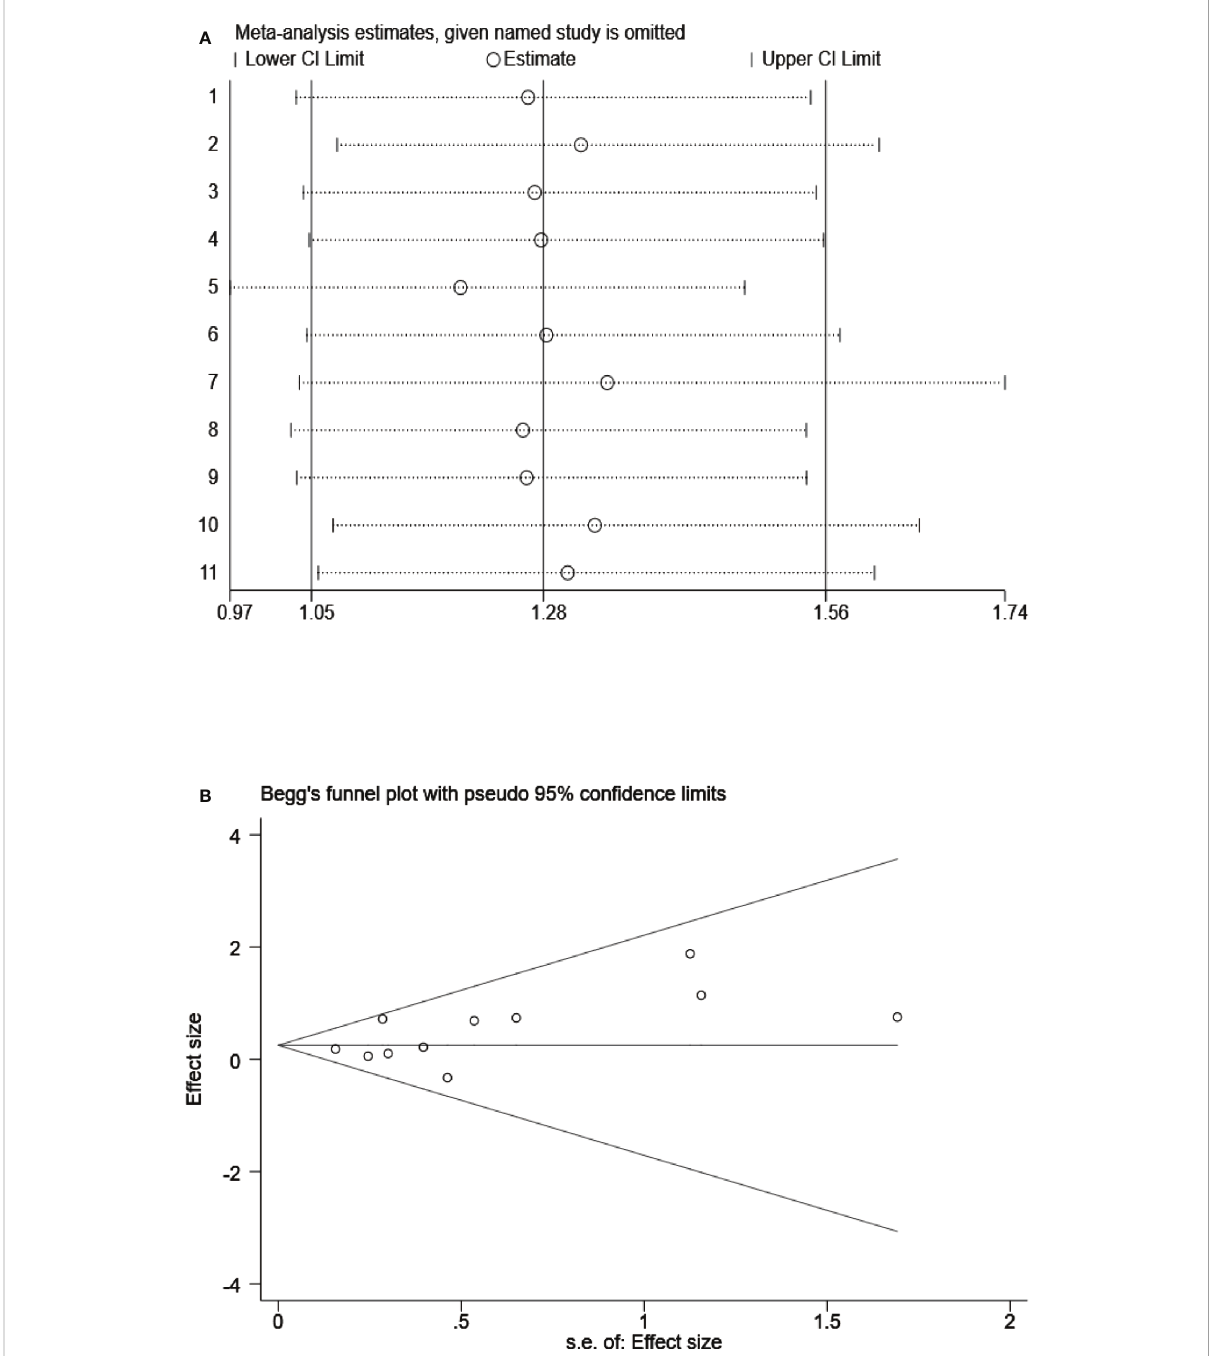
FIGURE 8 (A) Sensitivity analysis on the all included studies between Siglec-15 expression and OS. (B) Begg ’ s funnel plots of publication biases on the all included studies between Siglec-15 expression and